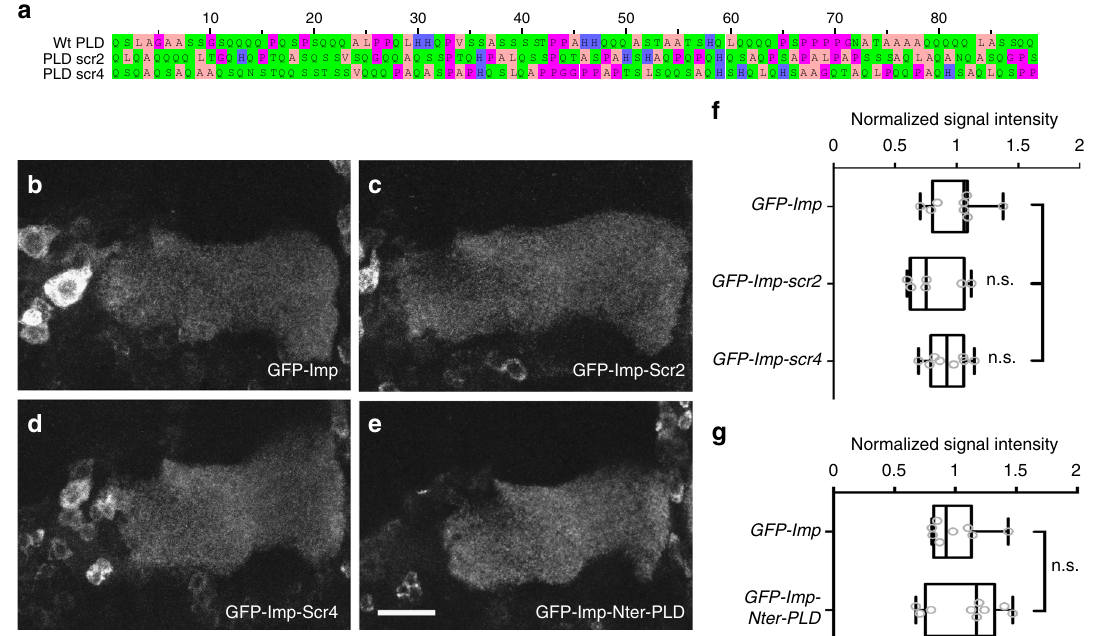
Fig. 4 Molecular requirements of PLD function in axonal localization. a Primary sequences of the wild-type (top) and scrambled (bottom) PLDs. Scramble variants were generated randomly and exhibit different degree of Glutamine dispersion. b – e Medial lobes of adult brains expressing GFP-Imp ( b ), GFP-Imp- Scr2 ( c ), GFP-Imp-Scr4 ( d ), or GFP-Imp-Nter-PLD ( e ) under the control of the 201Y-Gal4 driver. Genotypes: 201Y-Gal4/UAS-GFP-Imp or UAS-GFP-Imp- Scr2 or UAS-GFP-Imp-Scr4 or UAS-GFP-Imp-Nter-PLD. Scale bar in b – e : 15 μ m. f , g Distributions of normalized GFP signal intensities in distal axons. Box plots are represented using the min to max convention, where the middle line de fi nes the median and the whiskers go down to the smallest value and up to the largest. Numbers of MB analyzed: UAS-GFP-Imp: 8 (for f , g ); UAS-GFP-Imp-Scr2: 6; UAS-GFP-Imp-Scr4: 8; UAS-GFP-Imp-Nter-PLD:9. ns stands for not signi fi cant (Mann – Whitney test). Source data are provided as a Source Data fi